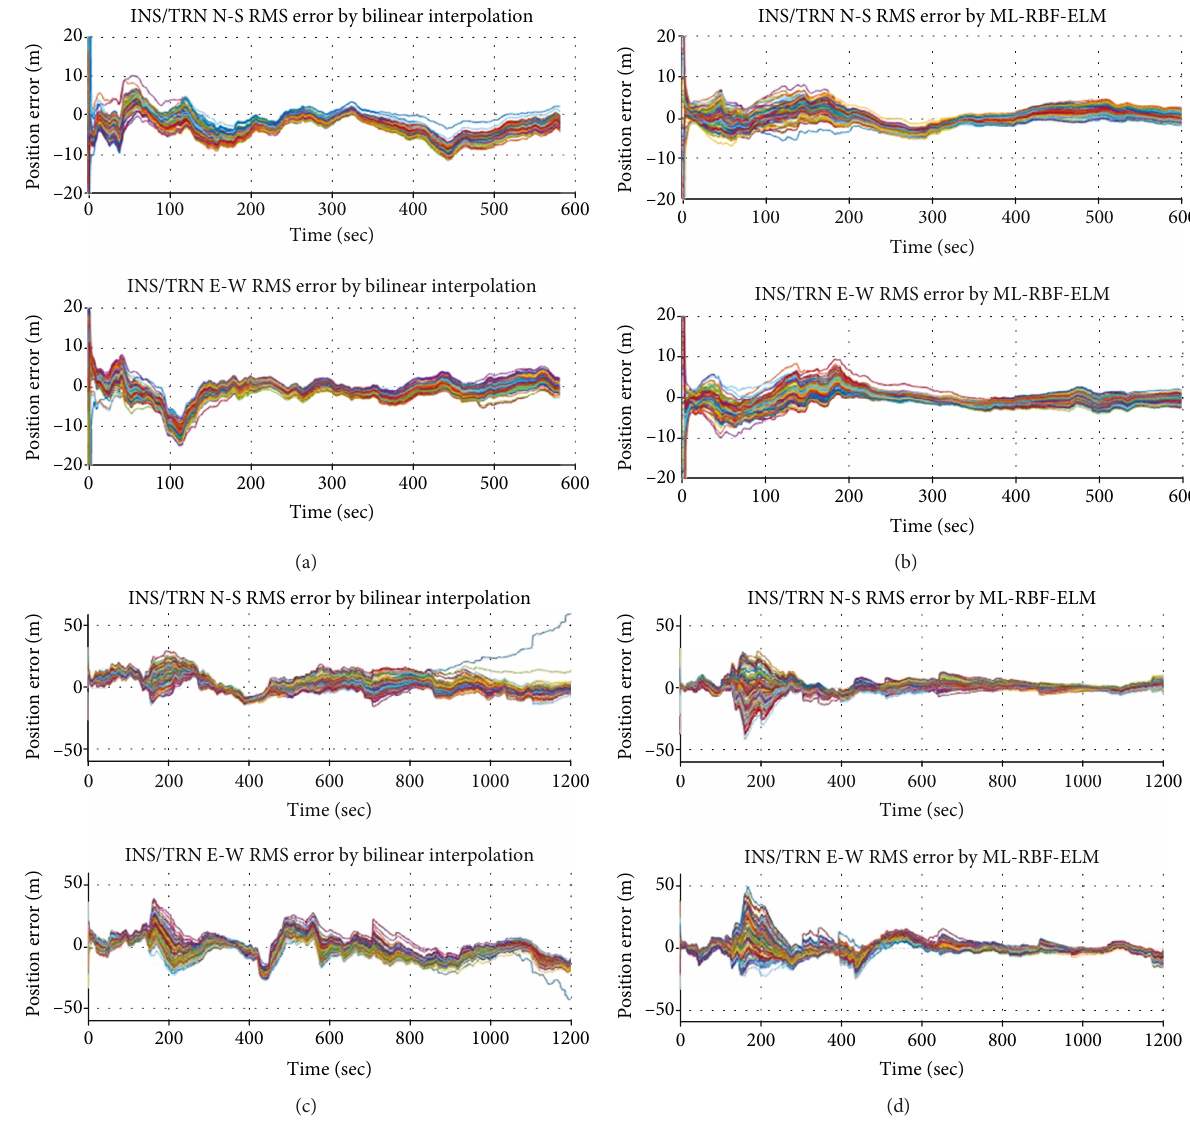
Figure 9: INS/TRN RMS errors. (a) Bilinear interpolation with DTED level 3. (b) ML-RBF-ELM with DTED level 3. (c) Bilinear interpolation with DTED level 2. (b) ML-RBF-ELM with DTED level 2.